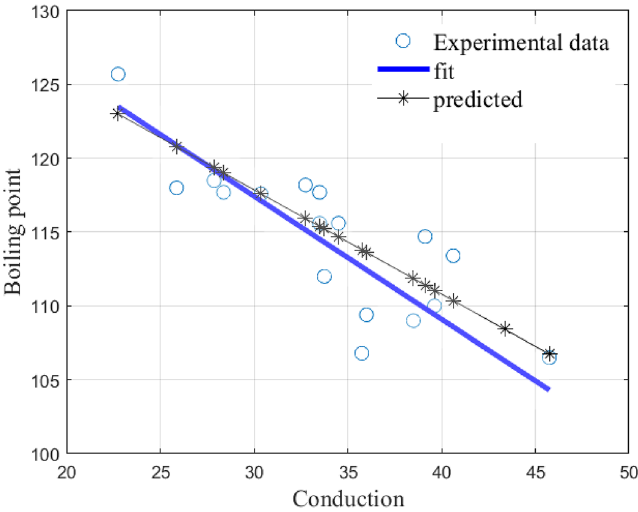
Figure 9. Shows a comparison of the linear least squares fit to experimental data and the linear model (8) for all alkanes of order